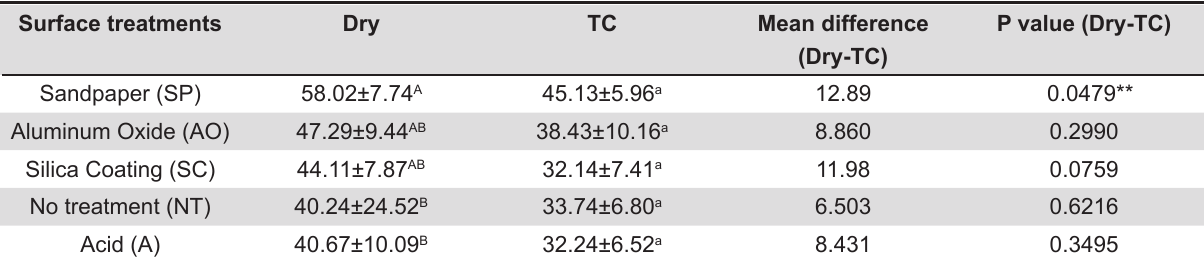
Table 2- Mean±SD of µTBS values (MPa) for each surface treatment in dry and thermocycled conditions and Sidak’s multiple comparisons test for each surface treatment (MPa) (SD=standard deviation) Surface treatments